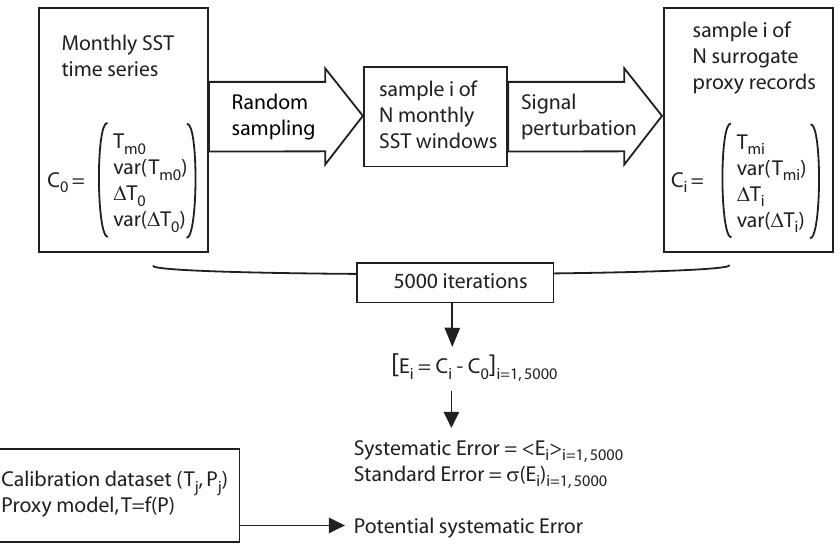
Fig. 1. Conceptual representation of the calculation of reconstruction errors in the MoCo algorithm.